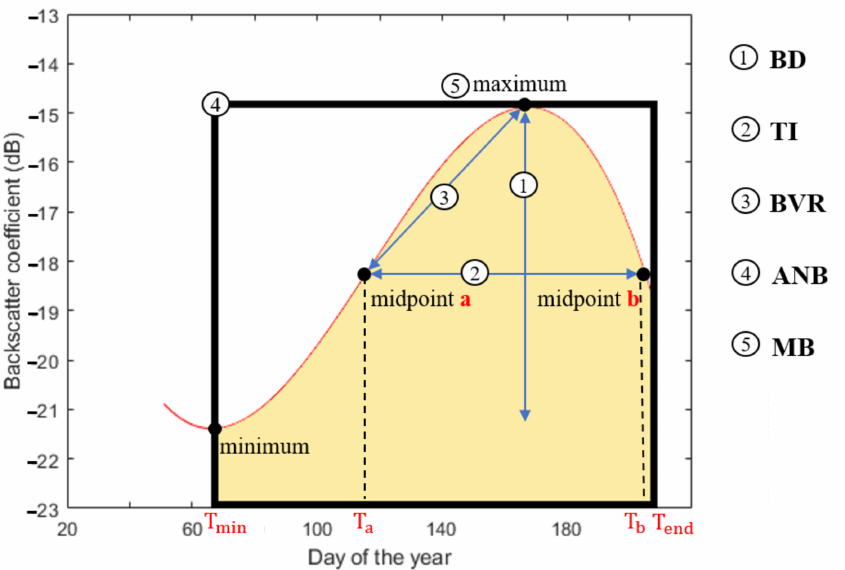
Figure 6. Extracted crop growth features. 1 (cid:13) Backscatter difference (BD), 2 (cid:13) time interval (TI), 3 (cid:13) backscatter variation rate (BVR), 4 (cid:13) average normalized backscatter (ANB) and 5 (cid:13) maximum backscatter (MB).